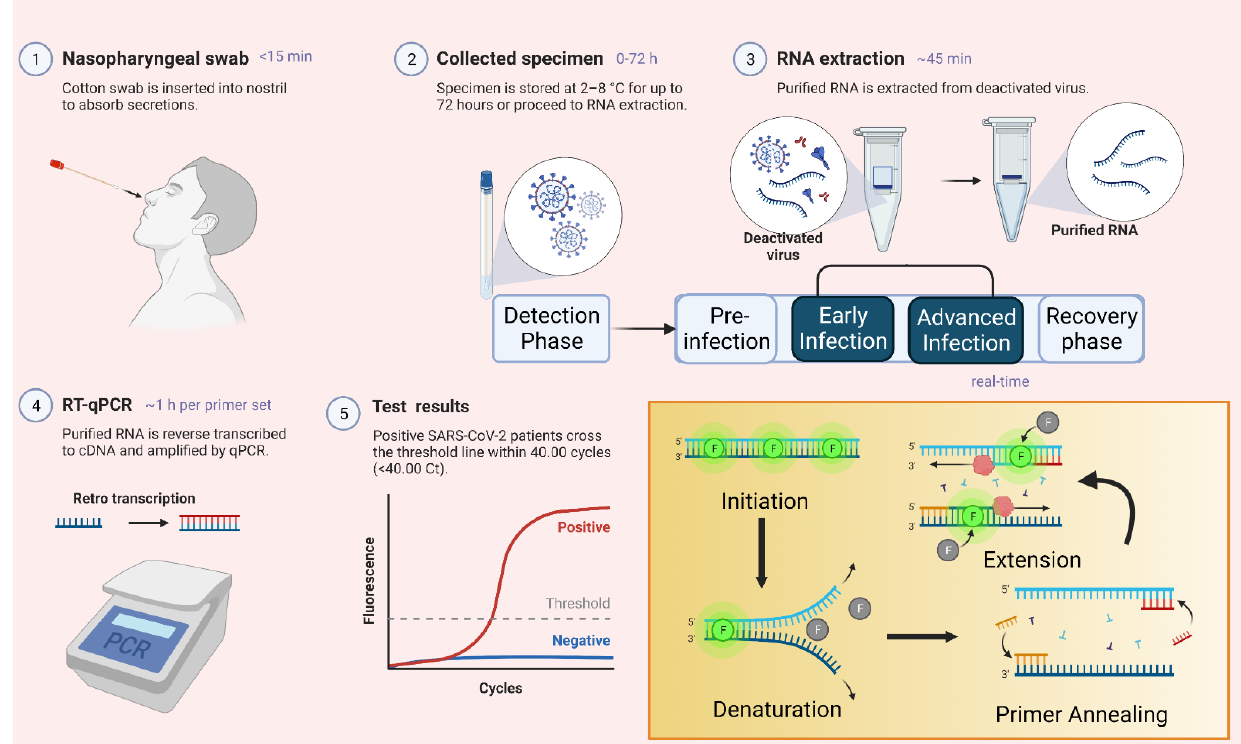
Figure 1. Methodology for RTPCR testing of COVID-19.